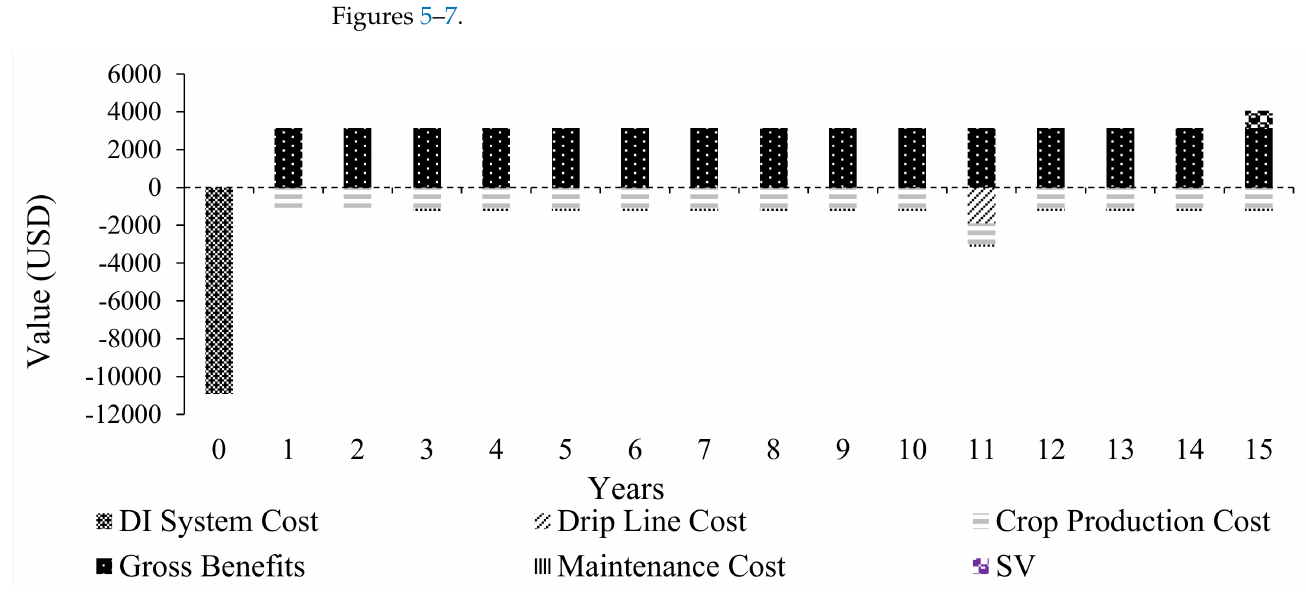
Figure 5. Cashflow diagram for solar power drip irrigation